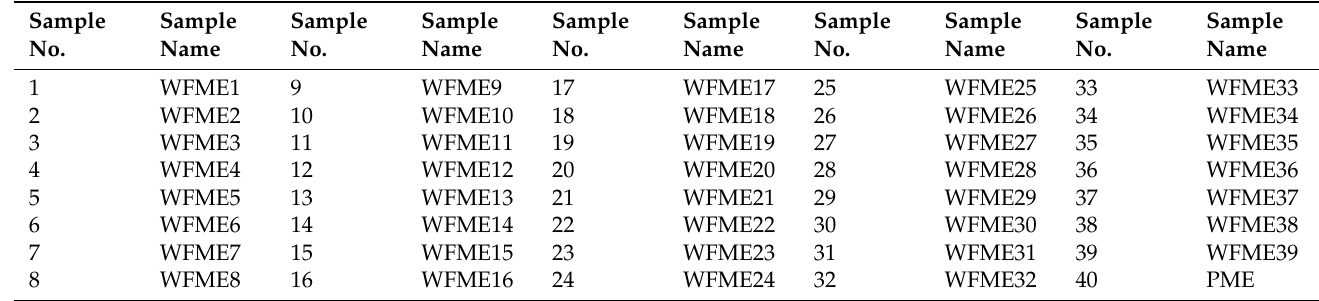
Table 9. Pure biodiesel samples used in this